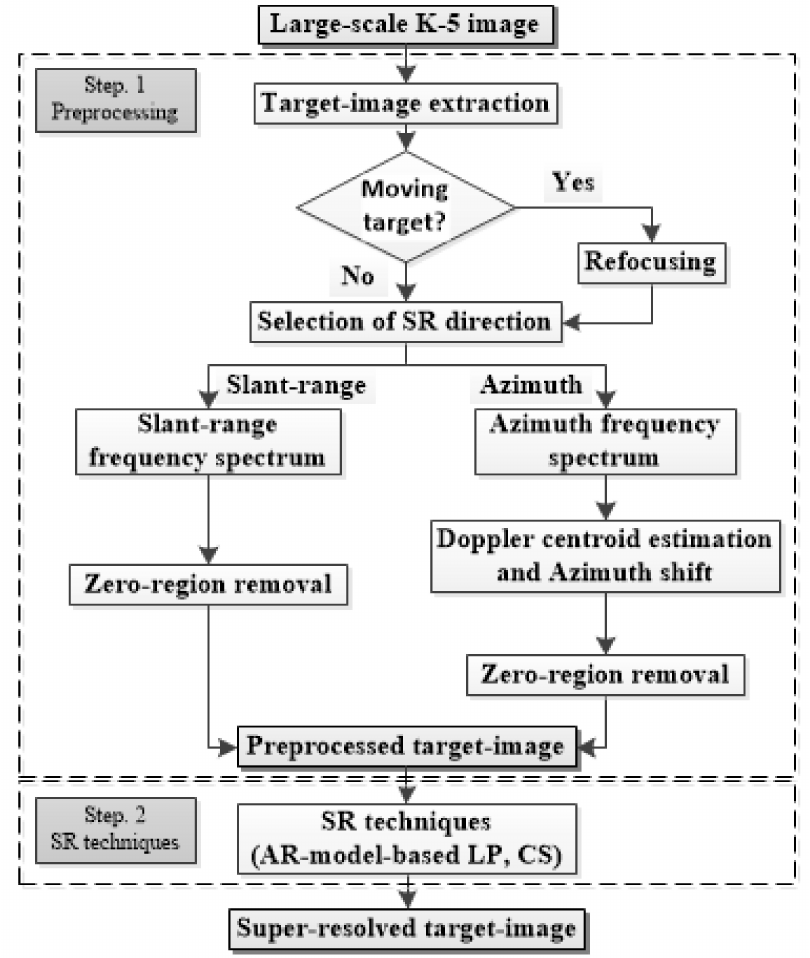
Figure 1. Overall flow of the proposed